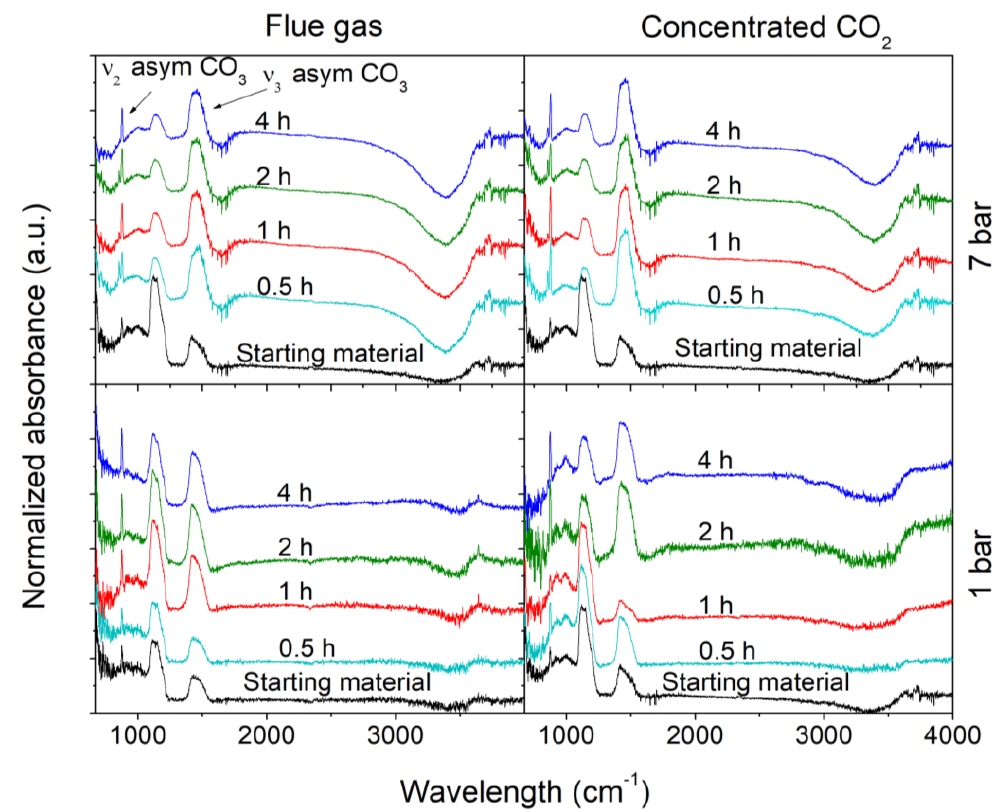
Figure 2. FTIR-ATR analysis of untreated and carbonated fly ash samples.